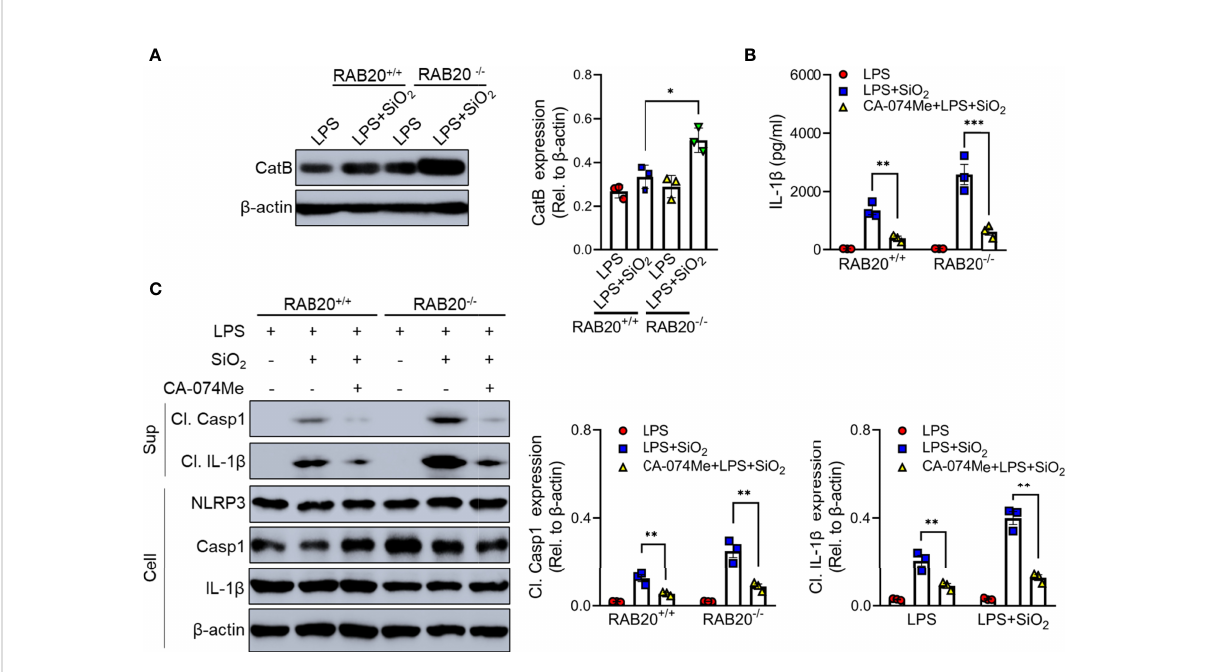
FIGURE 8 RAB20 knockout promotes the leakage of cathepsin B from lysosome to cytoplasm. (A) Immunoblotting for Cathepsin B and b -actin in the cytosolic fraction from RAB20 +/+ and RAB20 -/- mouse peritoneal macrophages stimulated with silica crystals after LPS priming. (B) IL-1 b secretion in wild type and RAB20 knockout peritoneal macrophages stimulated with SiO 2 after CA-074Me and LPS priming. (C) Immunoblotting for IL-1 b , caspase-1, NLRP3, and b -actin in the supernatants (SN) or cell lysates (cell) of wild type and RAB20 knockout mouse peritoneal macrophages stimulated with SiO 2 after CA-074Me and LPS priming. *p < 0.05; **p < 0.01; ***p < 0.001 (unpaired/two-tailed t test, one-way and two-way ANOVA test). Data are shown as mean ± SEM from three independent